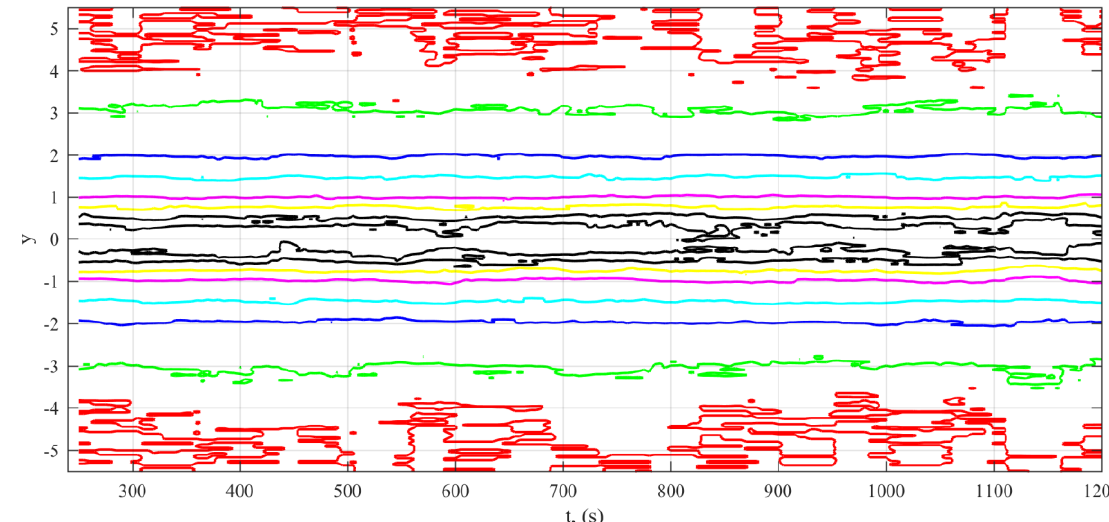
Figure 5. Underwater noise signal after AGC and normalization by the level. Lines of equal probability for consecutive probability density function (PDF) for T = 10 s, see Figure 4. This is lines of equal probability of the values of w(y): 0.000134 (red), 0.004432 (green), 0.053991 (blue), 0.1295 (cyan), 0.241971 (magenta), 0.3521 (yellow), 0.3867 (black). For the Gaussian distribution with the mean equal to 0 and variance equal to 1, this would be corresponding to the straight lines—also in accordance with values of y: ±4, ±3, ±2, ±1.5, ±1, ±0.5, ±0.25.